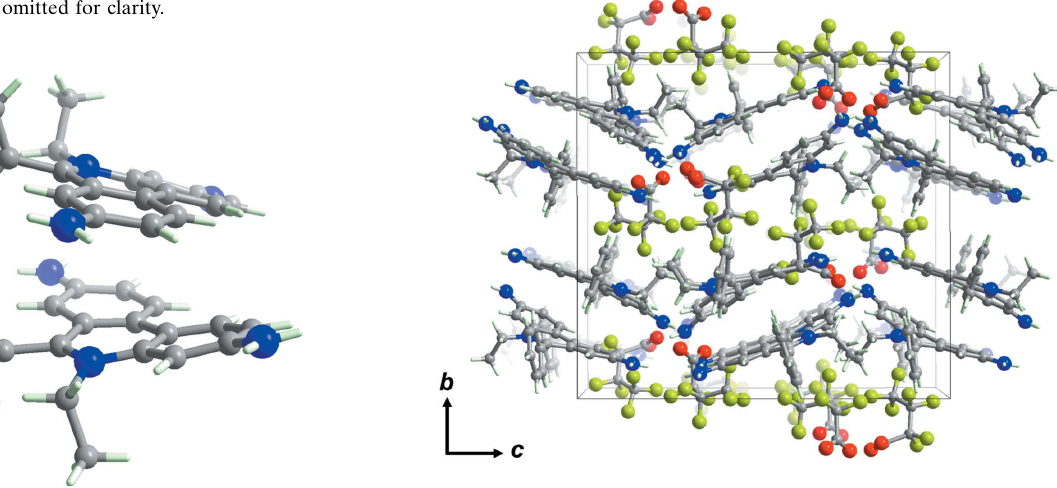
Figure 2 The dimerized structure of the ethidium cations.